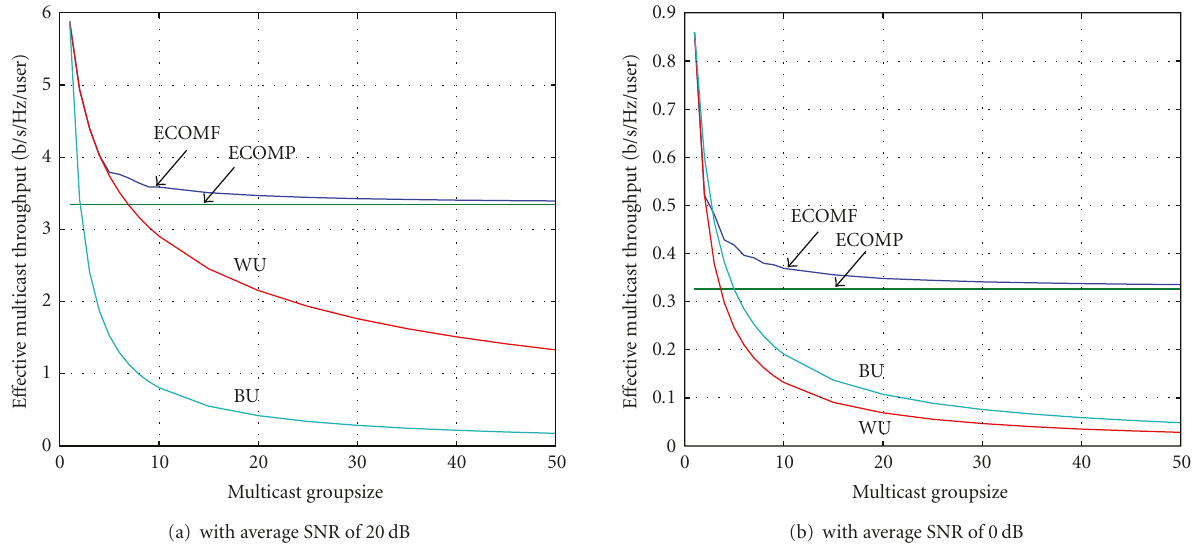
Figure 4: E ff ective multicast throughputs of di ff erent schemes versus number of users (over Rayleigh fading channels).